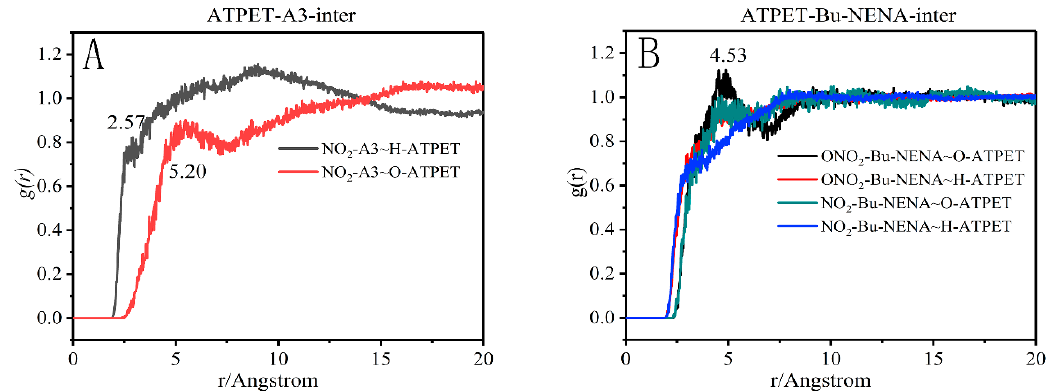
Figure 8. Radial distribution functions (RDFs) for different atoms of PTPET & A3( A ) / PTPET & Bu-NENA( B ).